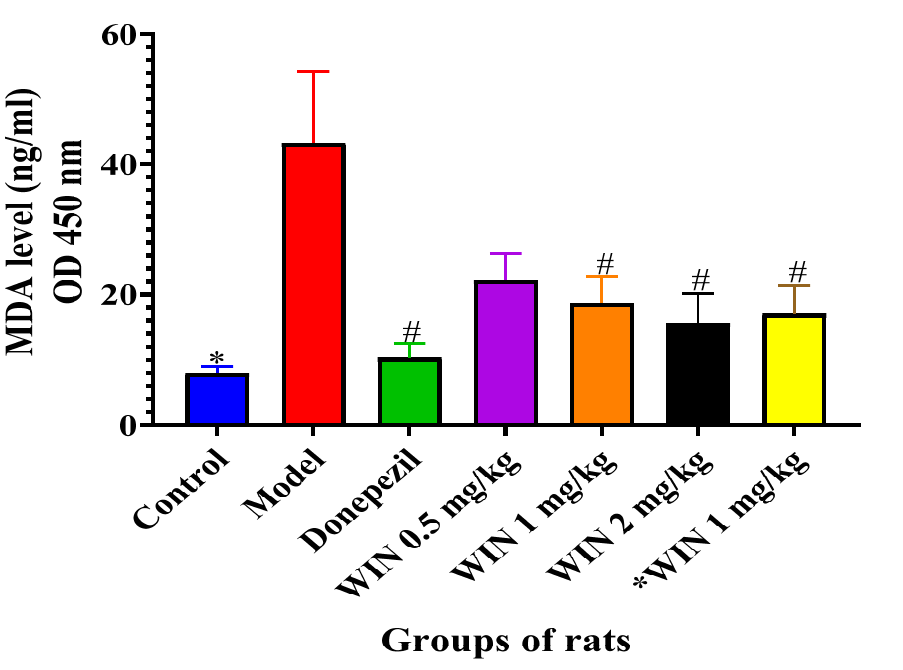
Figure 6. Effects of WIN on MDA activities in the brains of D -gal- and AlCl 3 -induced rats. Values are shown as mean ± SEM, n = 5. * p < 0.05 vs. model, # p < vs. control.